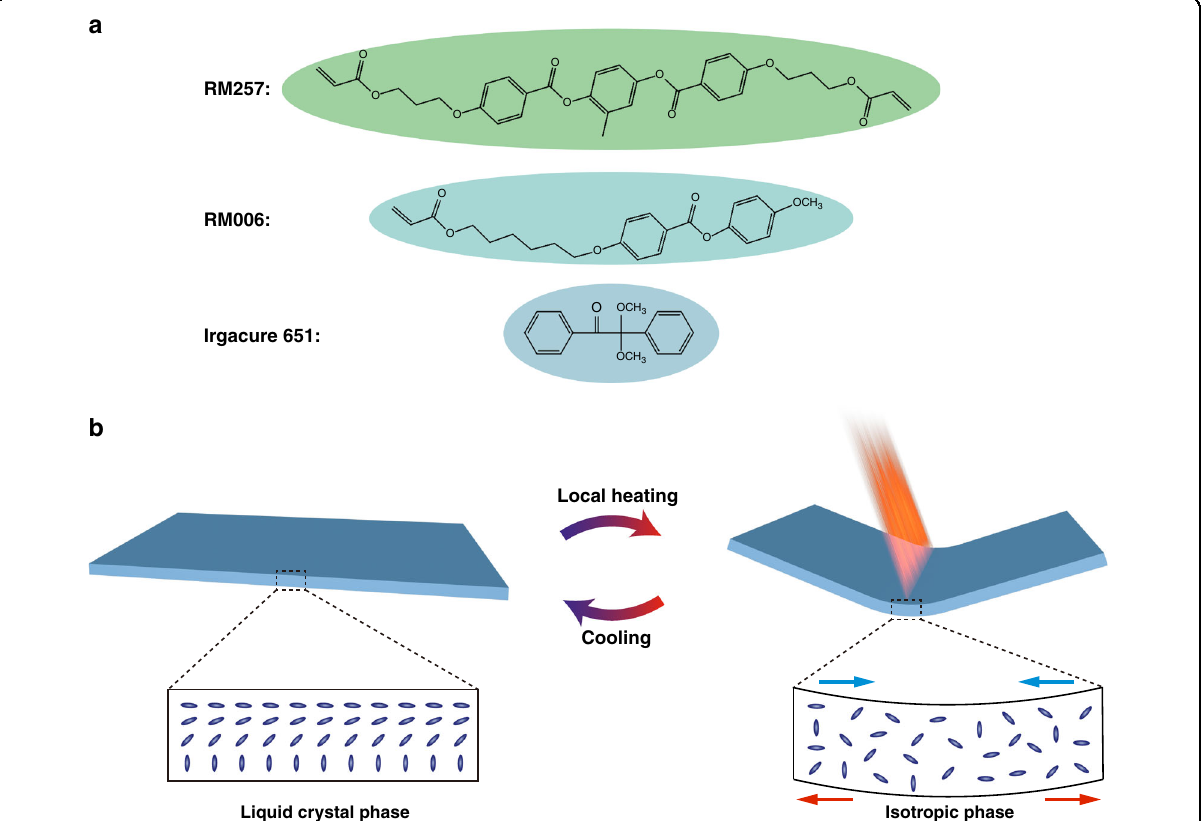
Fig. 1 The components of LCE and the mechanism of LCE deformation. a Chemical structure of the LCE components. b Schematic of the phase- change process of